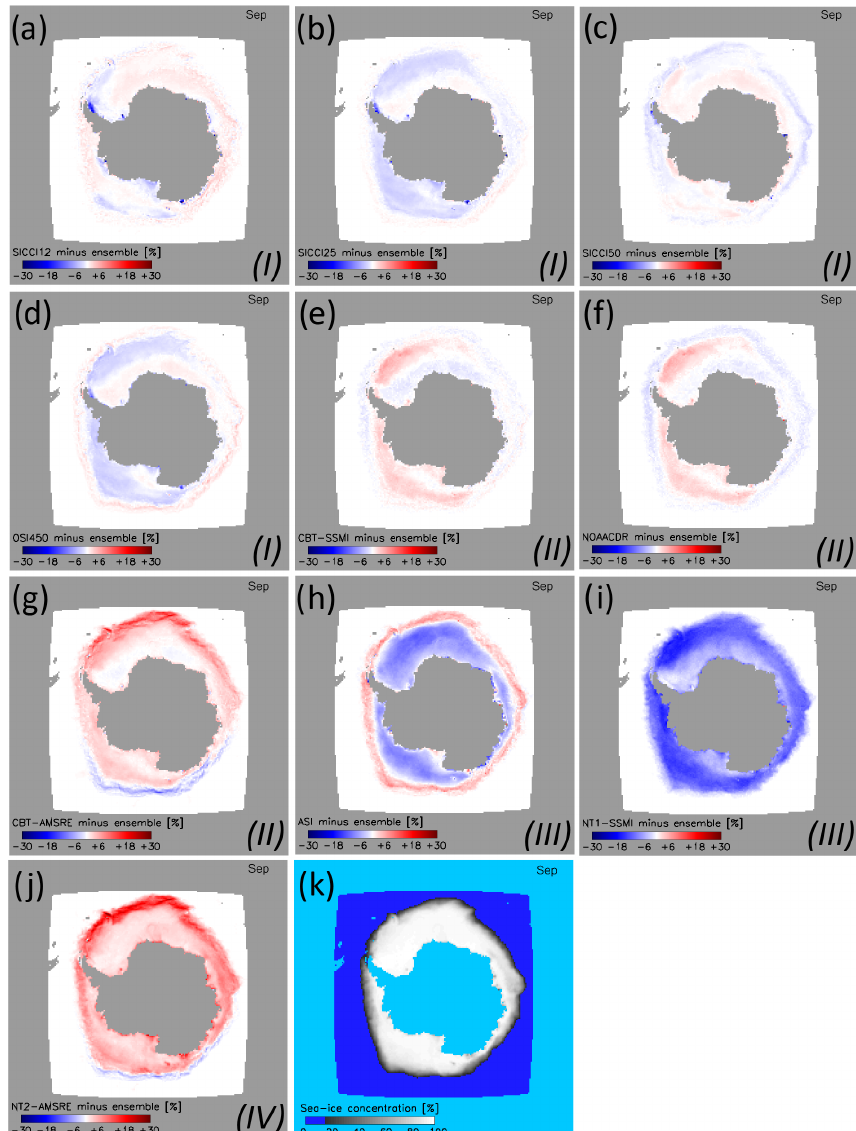
Figure 10. (a–j) Maps of the difference between the multi-annual average monthly SIC of the individual algorithms and the 10-algorithm ensemble median multi-annual average monthly SIC (k) for the Antarctic in winter (September) 2002–2011. Differences are only computed for sea-ice concentration of both data sets > 15%. Roman numbers I to IV denote the group assigned to the respective algorithm (see text for